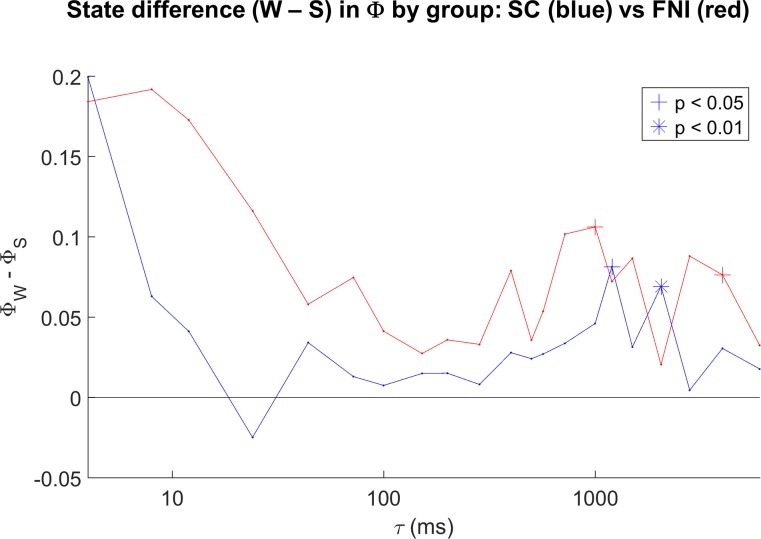
Sleep/wake differences for all computed values of τ.Results for the FNI and SC groups are shown separately in red and blue, respectively. The median over studies from 37 to 44 weeks postmenstrual age was used for each subject. Significant state differences (paired t-tests) are denoted by asterisks (p < 0.01) and crosses (p < 0.05).